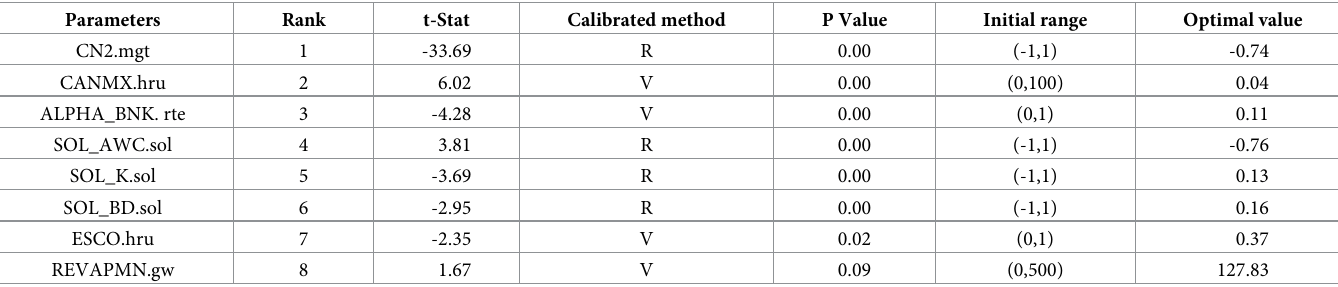
Table 3. The initial ranges and final values of the sensitivity parameters.